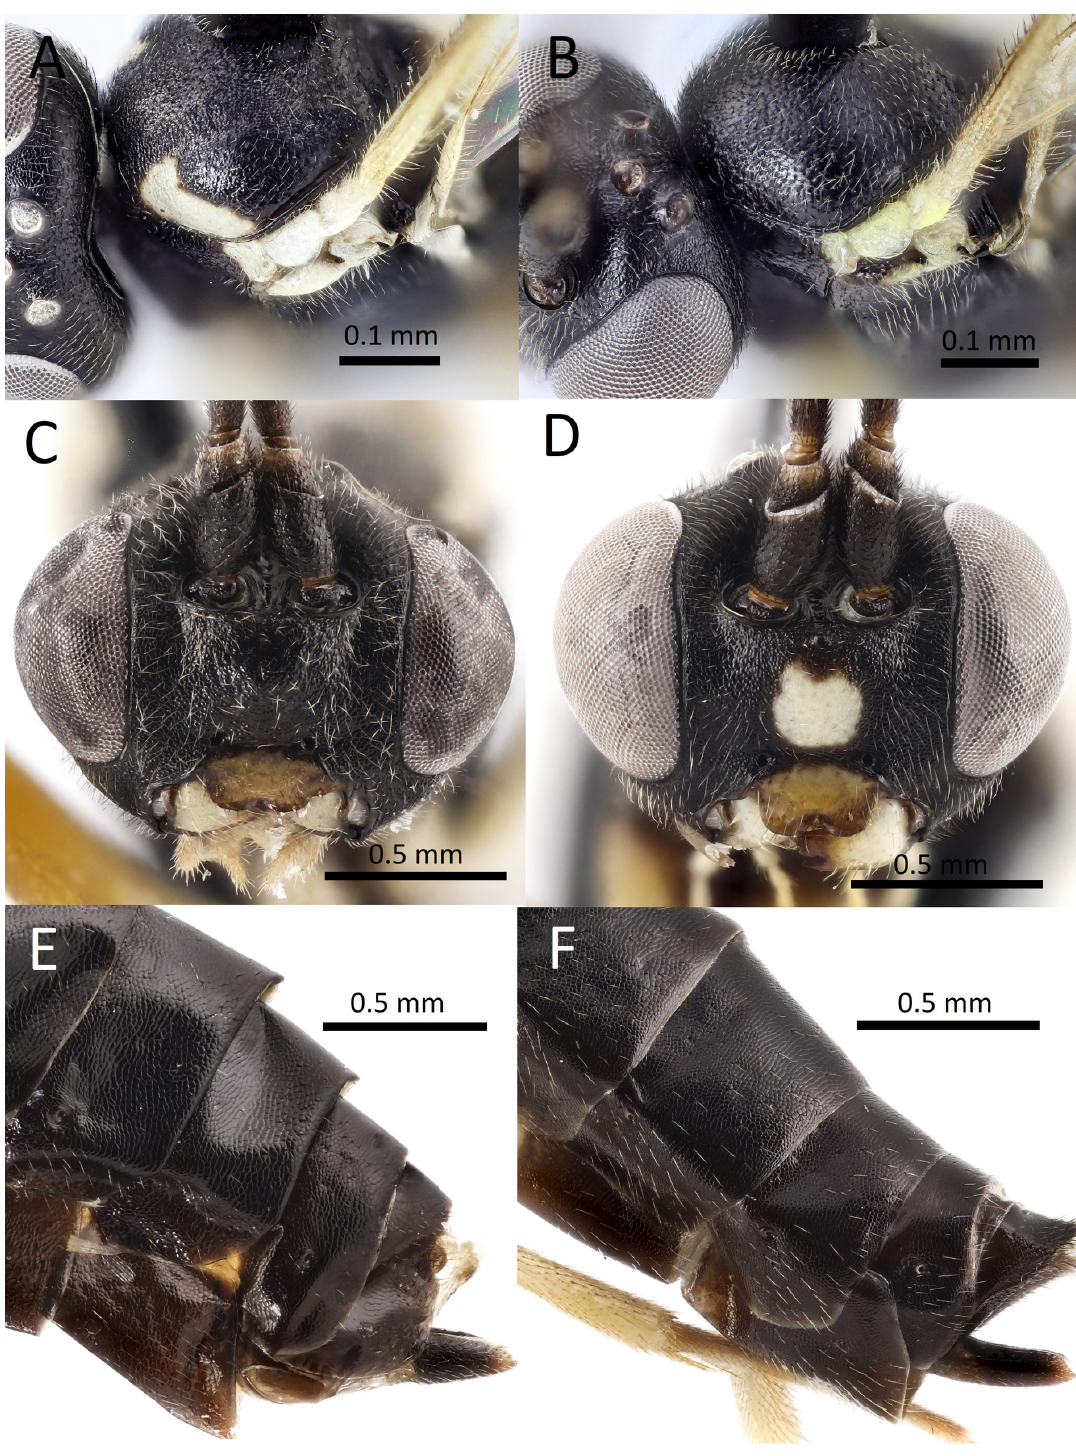
Fig. 5. A–B . Mesoscutum of female, anterodorsal view. A . Homotropus pallipes (Gravenhorst, 1829). B . Homotropus mugerwai sp. nov., paratype (NHRS-HEVA000011633). C–D . Head, anterior view of female. C . Homotropus hellqvisti sp. nov., paratype (NHRS-HEVA000011637). D . Homotropus collinus (Stelfox, 1941). E–F . Posterior segments of metasoma of female. lateral view. E . Homotropus melanogaster (Holmgren, 1872). F . Homotropus collinus